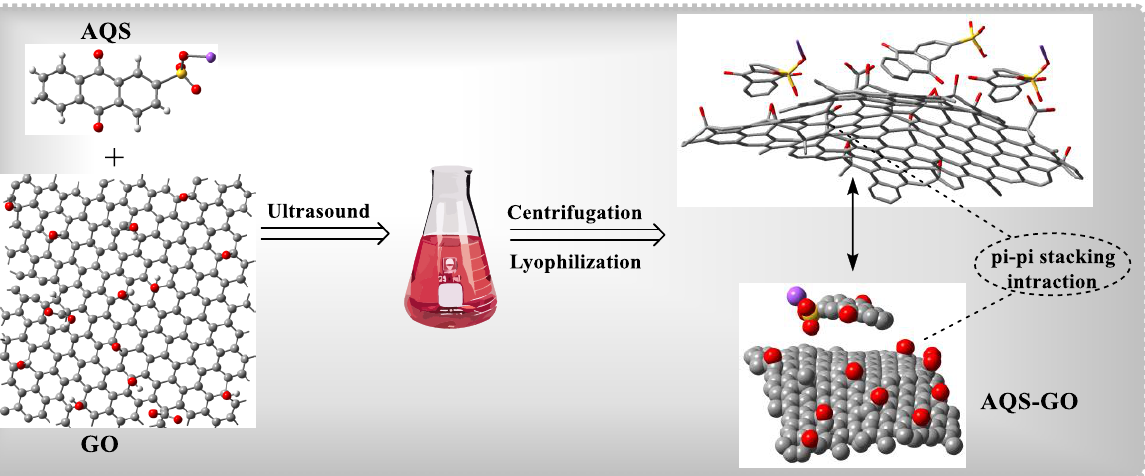
Figure 12. Loading of AQS onto GO, resulting in the AQS-GO nanocomposite through π – π inter- actions. “Reprinted from, Enhanced photo-induced antibacterial application of graphene oxide modified by sodium anthraquinone-2-sulfonate under visible light by Zhang, L.; Chen, P.; Xu, Y.; Nie, W.; Zhou, Y. Applied Catalysis B: Environmental 2020, 265, 118572. Copyright (2022), with permission from Elsevier [142] .”